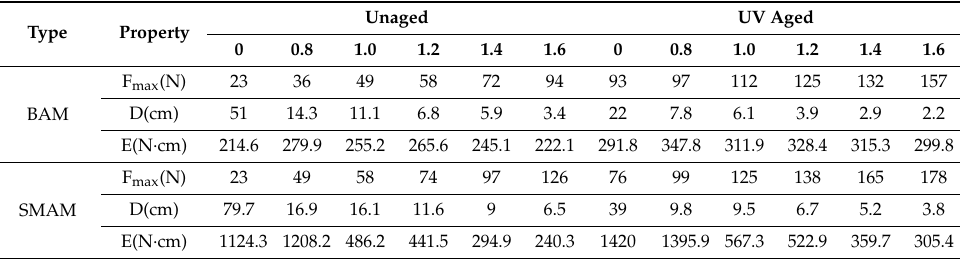
Table 5. Results of force-ductility test (10 ◦ C, 1 cm /